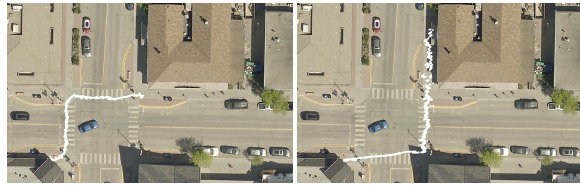
Figure 5. Individual pedestrian trajectories